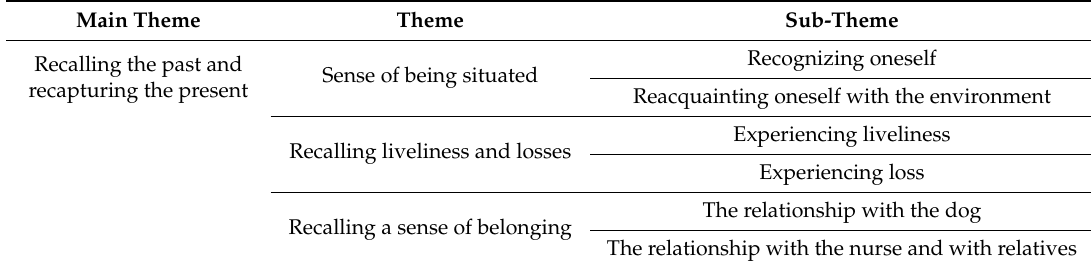
Table 1. Main theme, themes, and sub-themes from the structural